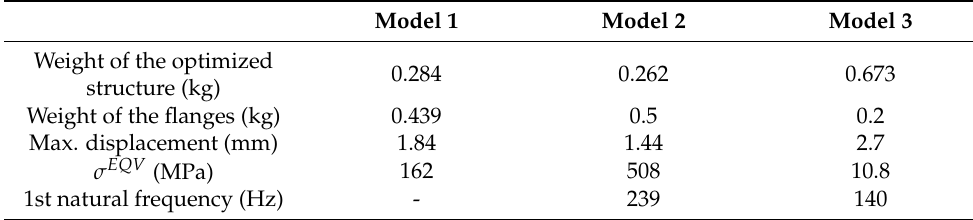
Table 9. Results for the three models of the